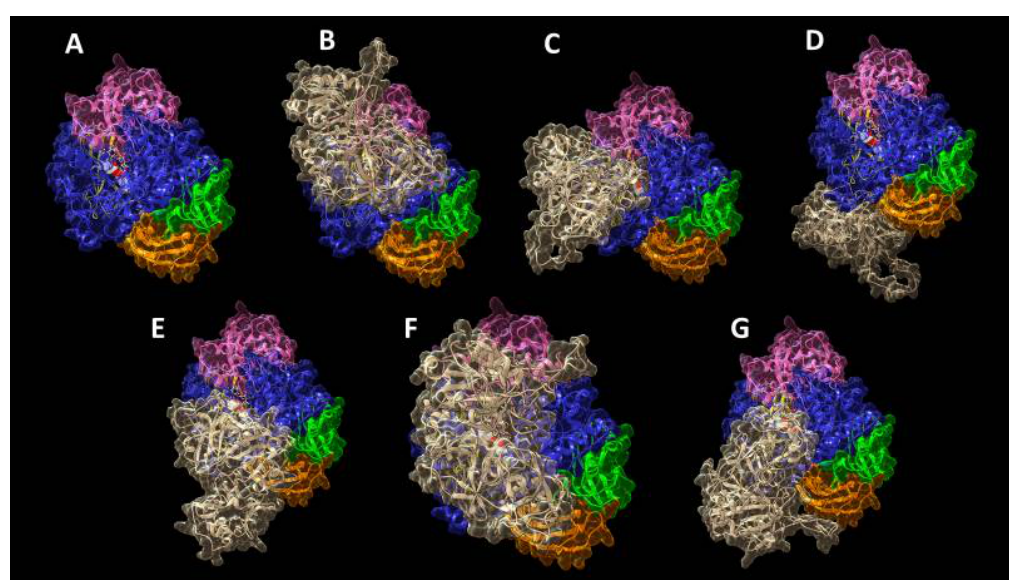
Figure 6. Docking results from all the tested software. ThMan2A catalytic domain is colored in blue, whereas structural domain 1 is pink, domain 2 is yellow, domain 4 is orange and domain 5 is green [55]. Catalytic amino acids E489 and E594 are represented as white spheres, and the substrate β-galactomannan is represented as white sticks. Refer to text for ThMan2A coloring details. L. albus γC is represented in tan color. Panel ( A ) shows ThMan2A alone; the others show the complex with γC as predicted by the pyDockWEB ( B ), ClusPro 2.0 ( C ), PRISM 2.0 ( D ), GRAMM-X ( E ), HDOCK ( F ) and FRODOCK ( G ) software. Atoms of the catalytic residues in the active site are white colored in spacefill representation to highlight the localization of the acid-base E489 and the nucleophile E594 [55].